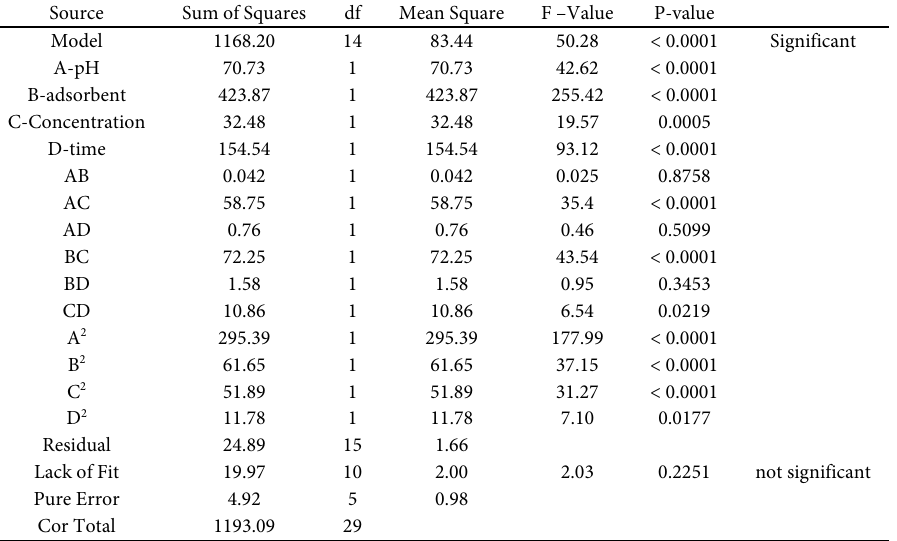
Table 4 ANOVA for Response Surface Quadratic model. Table 4. ANOVA for Response Surface Quadratic